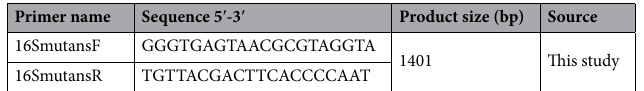
Table 1. Oligonucleotides used in this